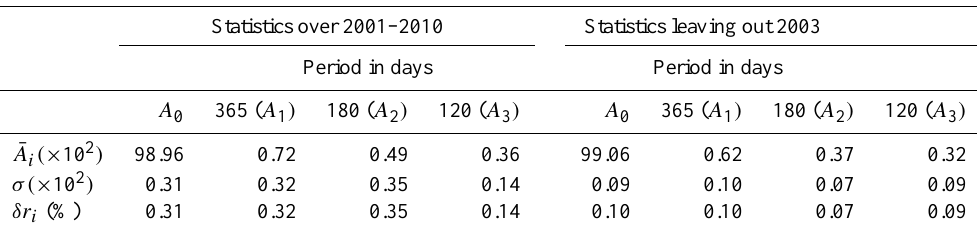
Table 4. Comparison of the statistics (mean ( ¯ A i ) , standard deviation ( σ) and coefficient of variation δr i ) of the mean ratio r and harmonic amplitudes calculated over the period 2001–2010.